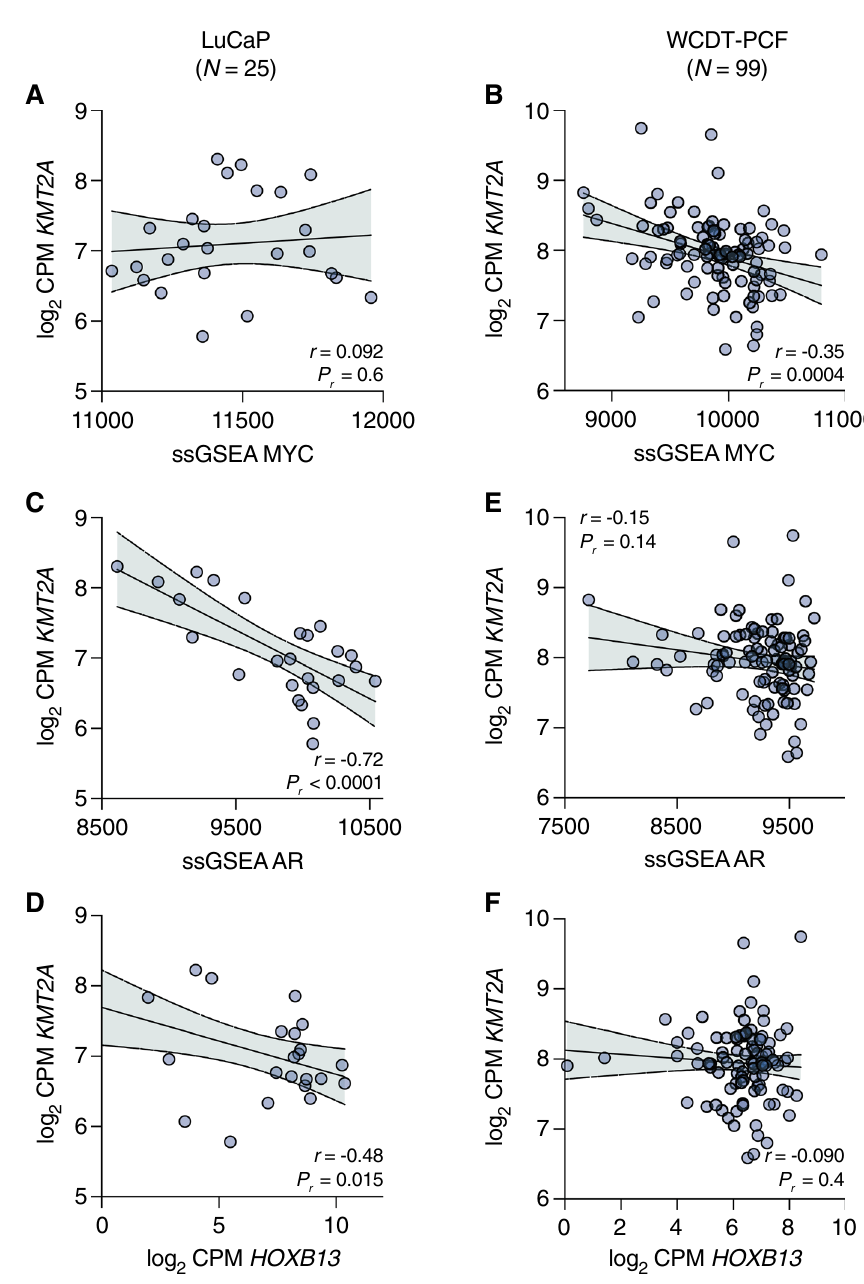
Fig. 3 Inverse association of KMT2A expression with pros- tate cancer drivers in meta- static disease. A – F Pearson correlation of the log CPM 2 expression level for KMT2A with the 54-gene ssGSEA MYC activity score ( A , B ), a 266-gene ssGSEA AR activity score ( C , E ), or the log CPM 2 expression level for HOXB13 ( D , F ) in the LuCaP series of patient-derived xenografts ( N = 25) ( A , C , D ) or the West Coast Dream Team-Prostate Cancer Foundation metastatic CRPC cohort ( N = 99) ( B , E , F ). The error bars represent the 95% confidence bands for linear